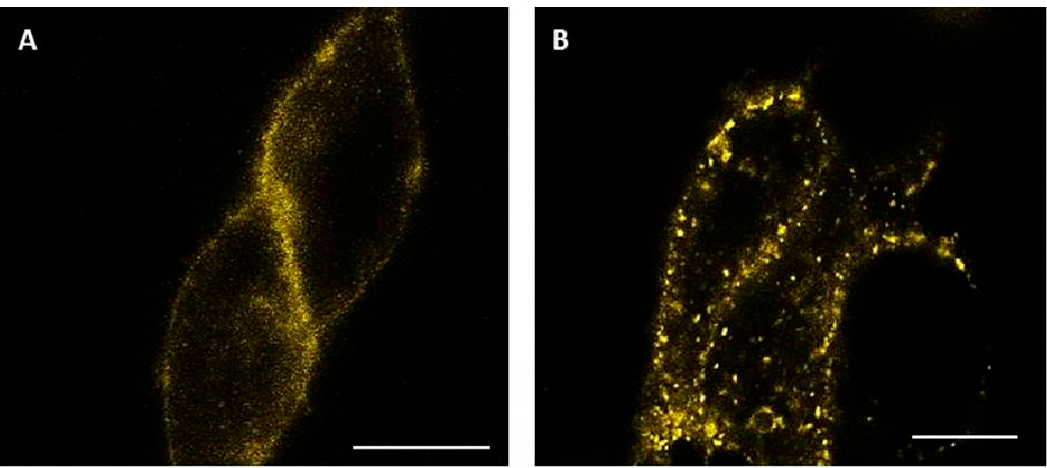
Figure 5. Agonist induced internalization of GLP-1R-YFP. Confocal images were taken before ( A ) and 5 min after ( B ) stimulating cells expressing GLP-1R-YFP with 1 µM GLP-1. Scale bar = 10 µm.